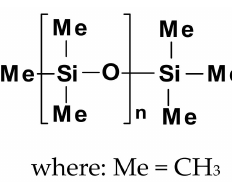
Figure 2. Chemical structure of the nonreactive methylsilicone oil.